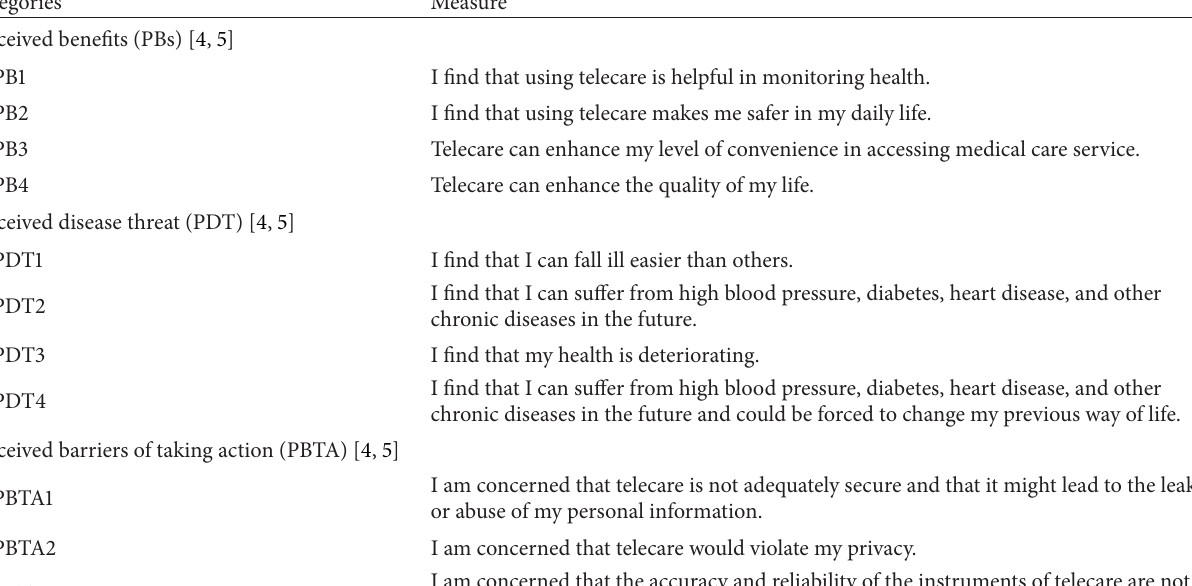
Table 1: Reliability and validity